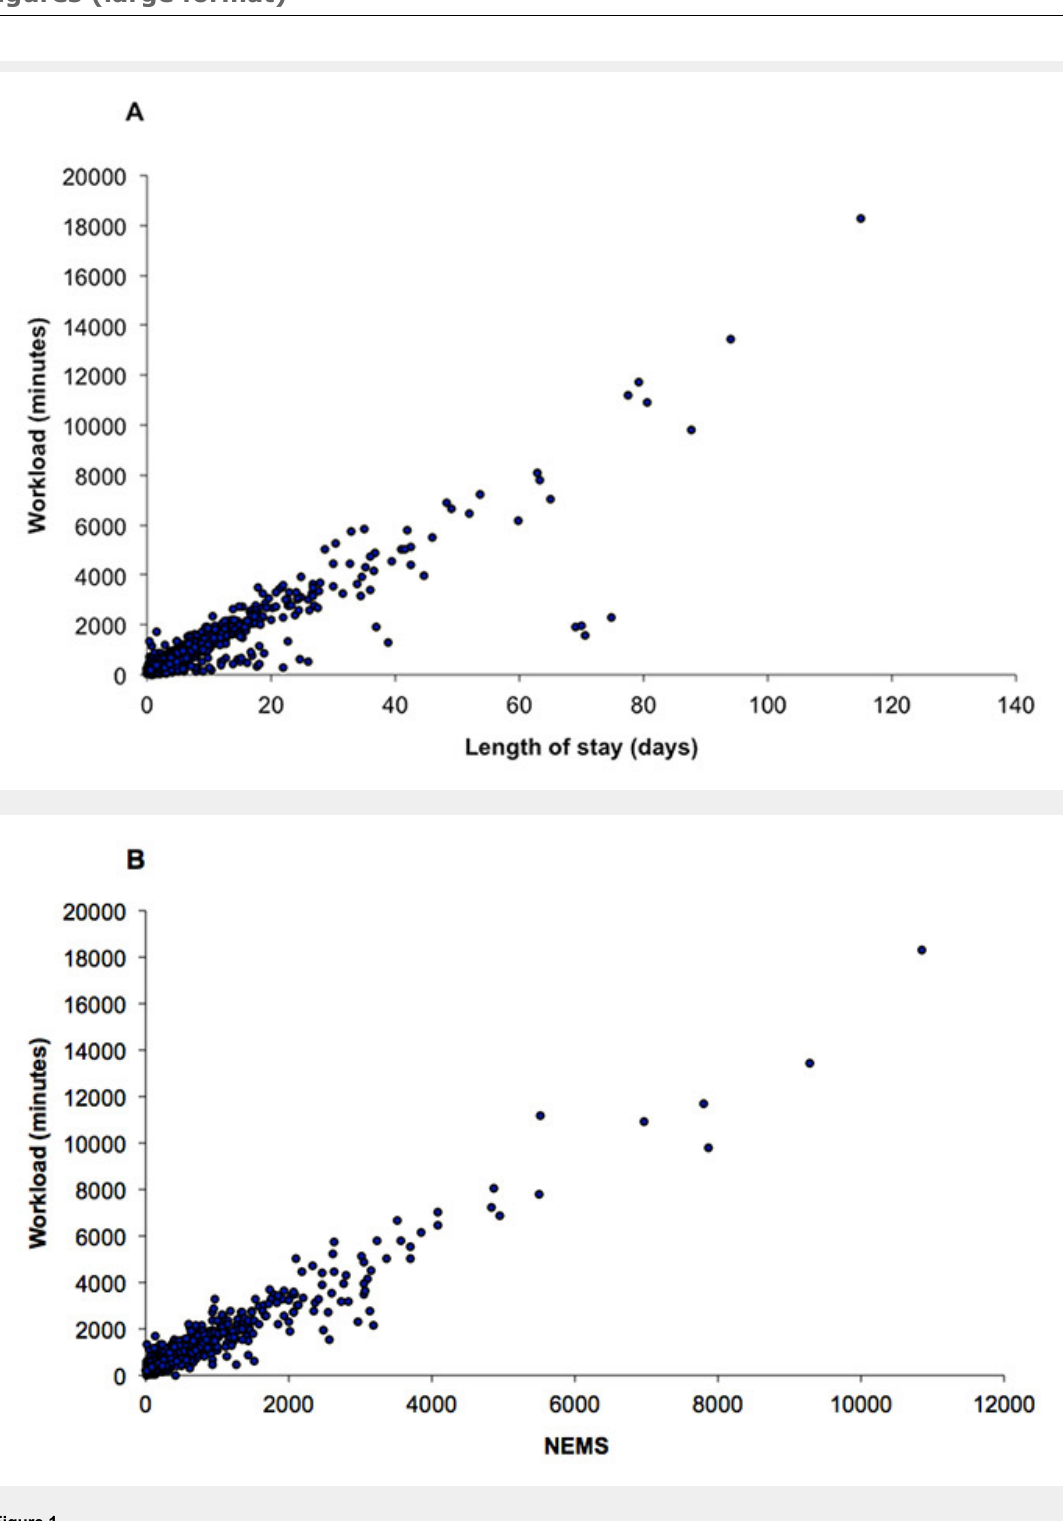
Figure 1 Bivariate scattergram for the relationship between workload and LOS (fig. 1A) and between workload and NEMS (fig. 1B). (n =